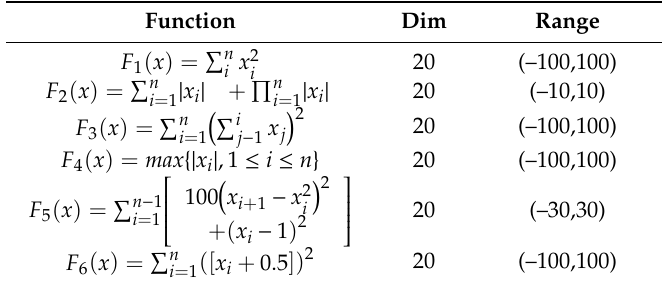
Table 2. Description of classical benchmark mathematical functions.